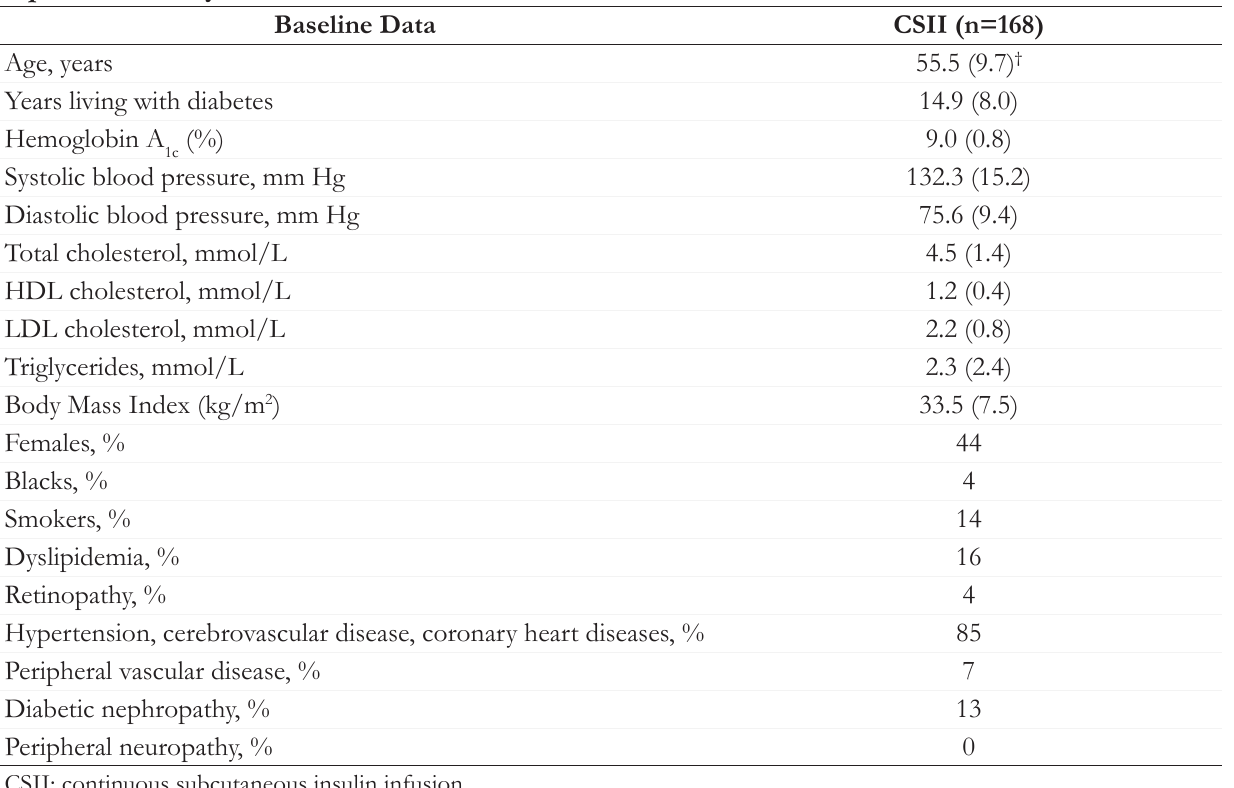
Table 1. Population Characteristics at Baseline in the Group that Received CSII Treatment in the OpT2mise Study